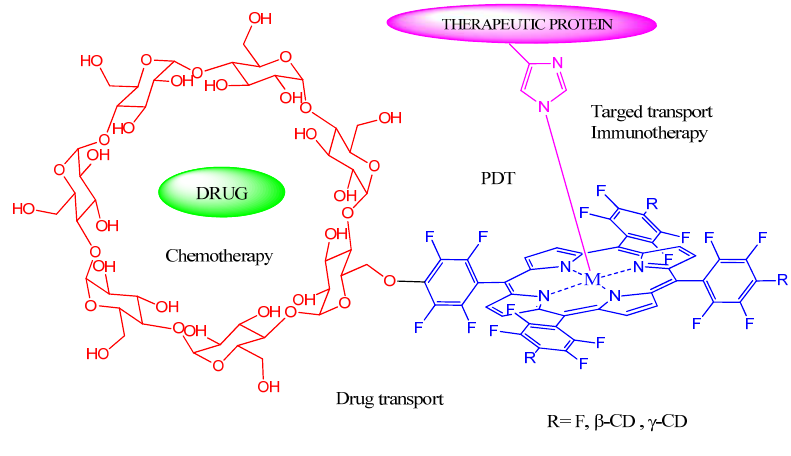
Figure 6. Therapeutic protein coordinated drug delivery system ( 6